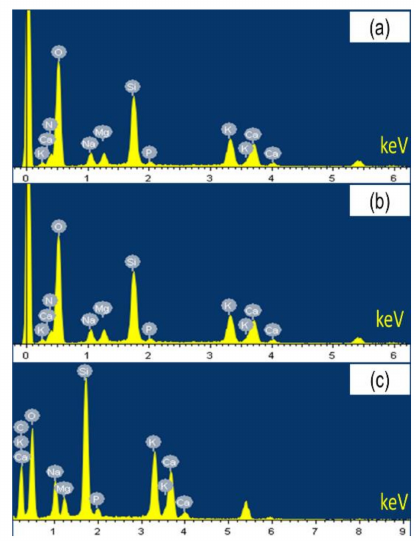
Figure 5. EDS compositional analysis performed on DG-120 ( a ), SG-625 ( b ) and SG-800 ( c ) sol-gel